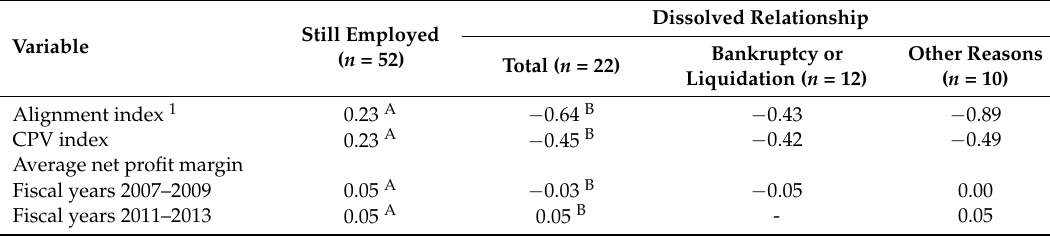
Table 4. Relation between relationship status and customer–contractor alignment; customer-perceived value of harvesting services; and contractor